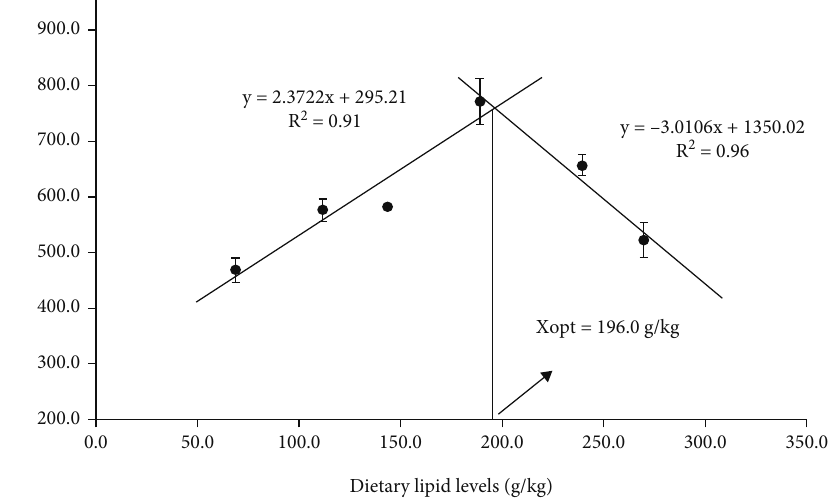
Figure 1: Relationship between weight gain (%) and dietary lipid levels based on linear broken-line model analysis, where Xopt represents the optimal dietary lipid level for the maximum weight gain of Acanthopagrus schlegelii . Each point represents the mean of three replicates per